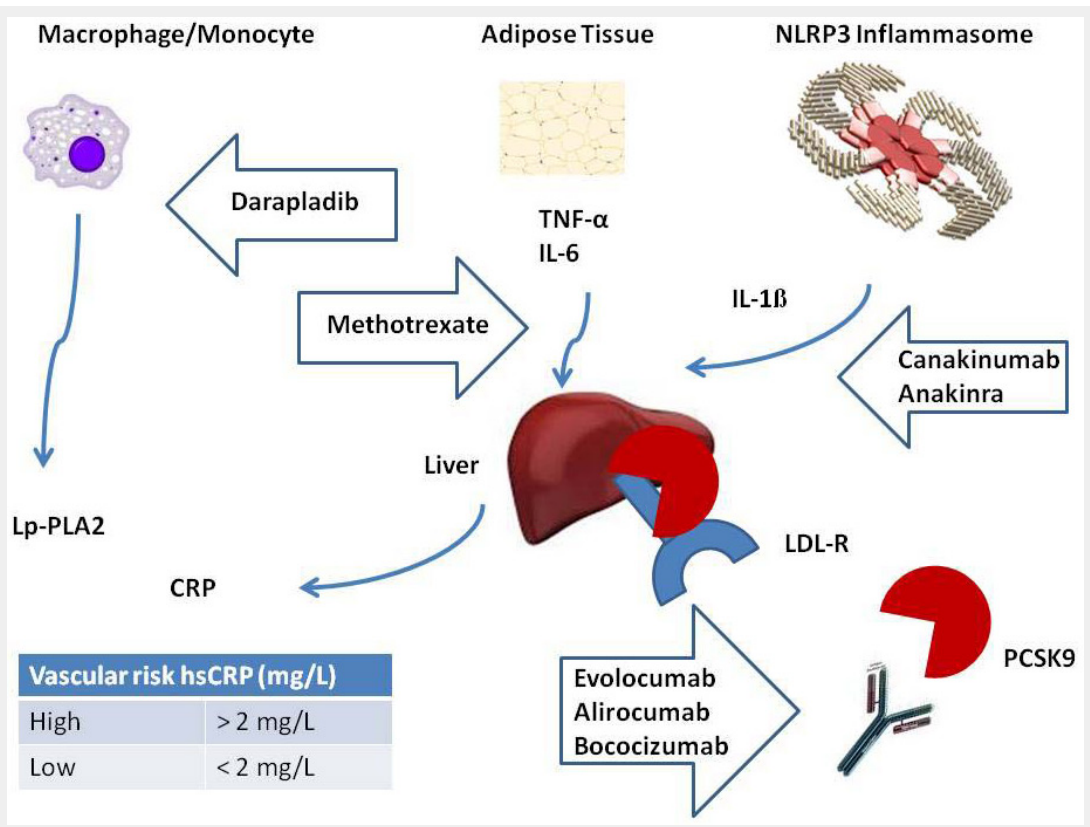
Targeting inflammatory and lipid pathways for the treatment of cardiovascular disease. Monoclonal antibodies against PCSK9 (evolocumab, alirocumab and bococizumab) decrease circulating LDL-C by an increase of LDL-R at the hepatocyte surface. Monoclonal antibodies against IL-1β (canakinumab) are currently being tested in the CANTOS trial [37]. Anakinra, an inhibitor of IL-1β, has been tested in the VCU-ART studies [46]. Methotrexate, an inhibitor of TNFα, IL-6 and hsCRP, is currently being tested in the CIRT trial [38]. Darapladib has been tested in the SOLID-TIMI 52 and STABILITY trials [44, 45]. CANTOS = Canakinumab Anti-inflammatory Thrombosis Outcomes Study; CIRT = Cardiovascular Inflammation Reduction Trial; hsCRP = high- sensitive C-reactive protein; IL = interleukin; LDL-C = low-density lipoprotein cholesterol; LDL-R = low-density lipoprotein receptor; PCSK9 = proprotein convertase subtilisin / kexin type 9; SOLID-TIMI 52 = stabilization of plaque using darapladib-thrombolysis in myocardial infarction 52; STABILITY = stabilization of atherosclerosis plaque by initiation of darapladib therapy. TNF = tumour necrosis factor; VCU-ART = Virginia Commonwealth University anakinra remodeling trial. Figure adapted from Ridker